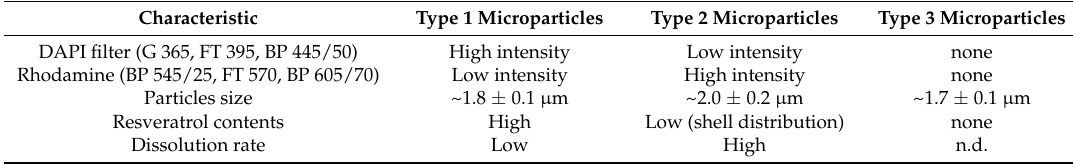
Table 1. Principle features of microparticles of RSV@MDH.